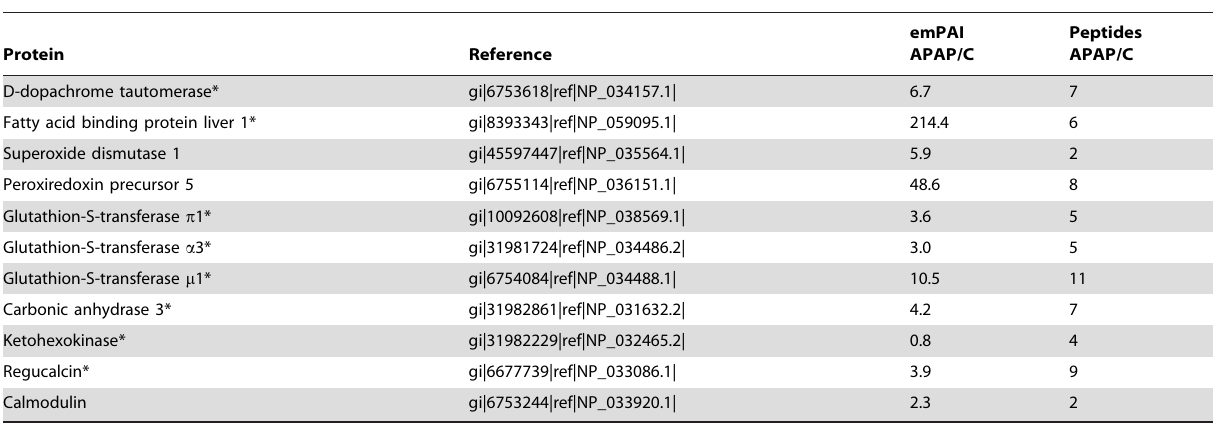
Table 3. Proteins identified with